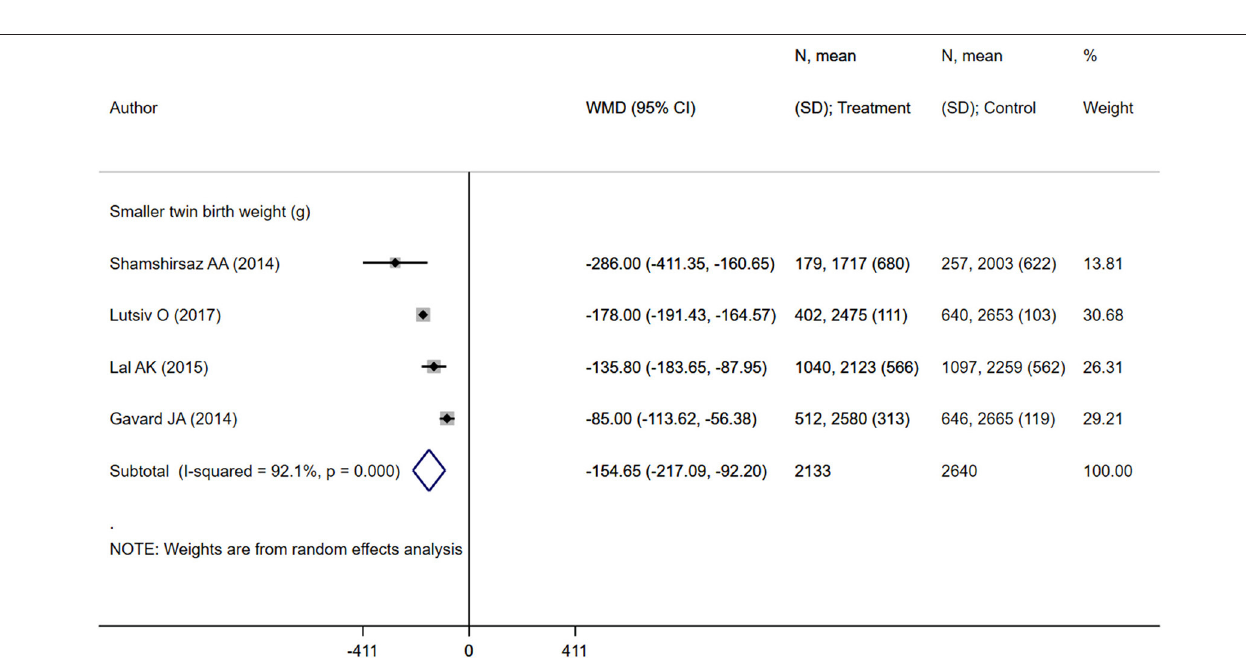
FIGURE 5 | Pooled analysis of inadequate or adequate pregnancy weight gain effects on maternal health outcomes mean birth weight.